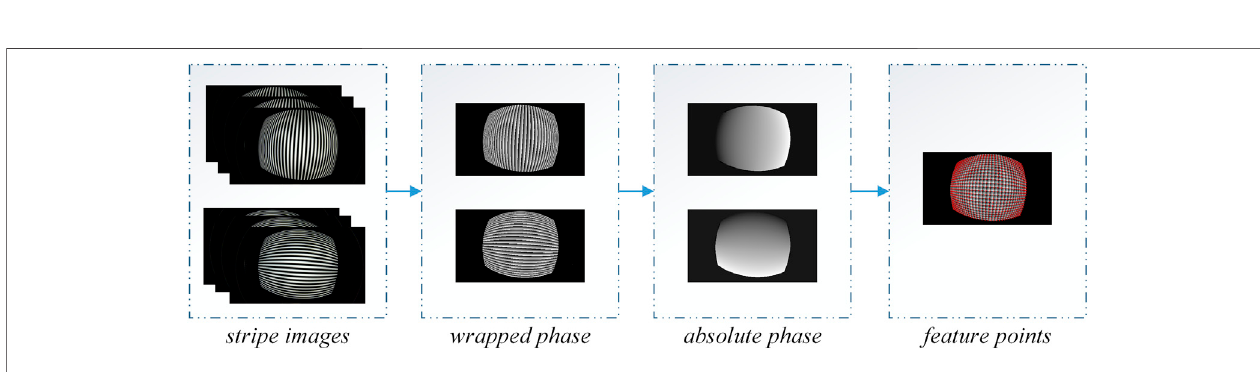
FIGURE 4 | Feature extraction